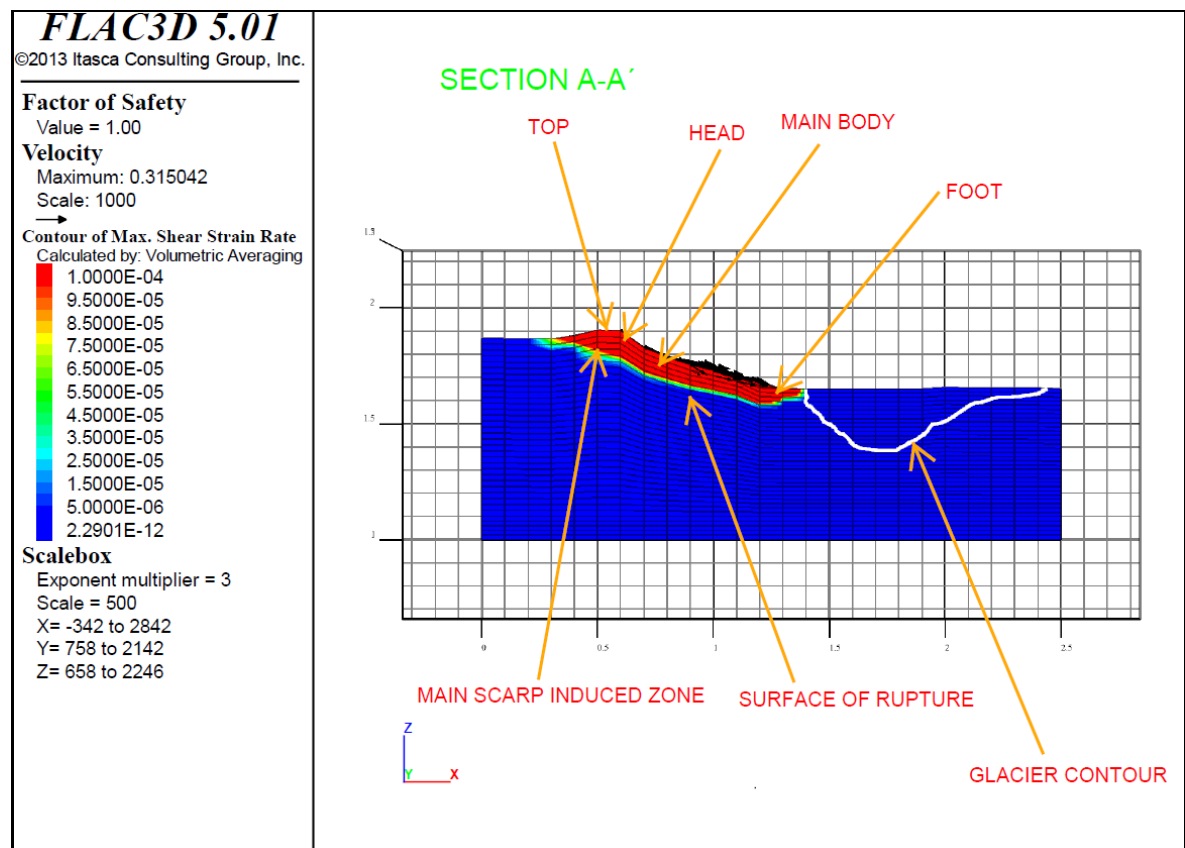
Figure 8. Main section A-A’ (marked in Figure 7) of the landslide from the numerical simulation.